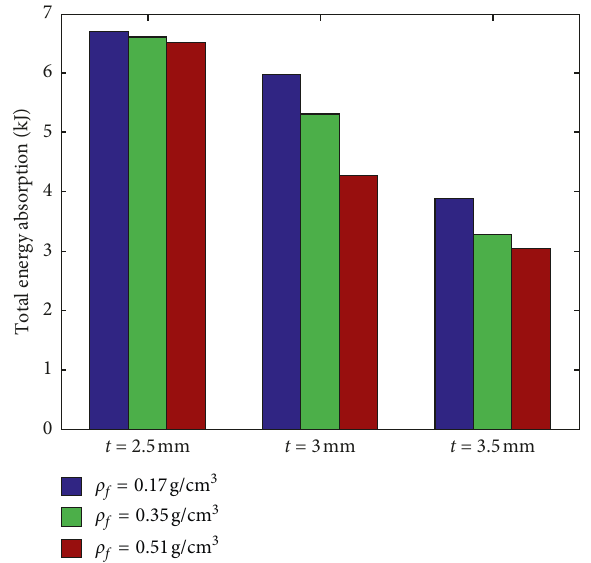
Figure 21: Total energy absorption of FTS.